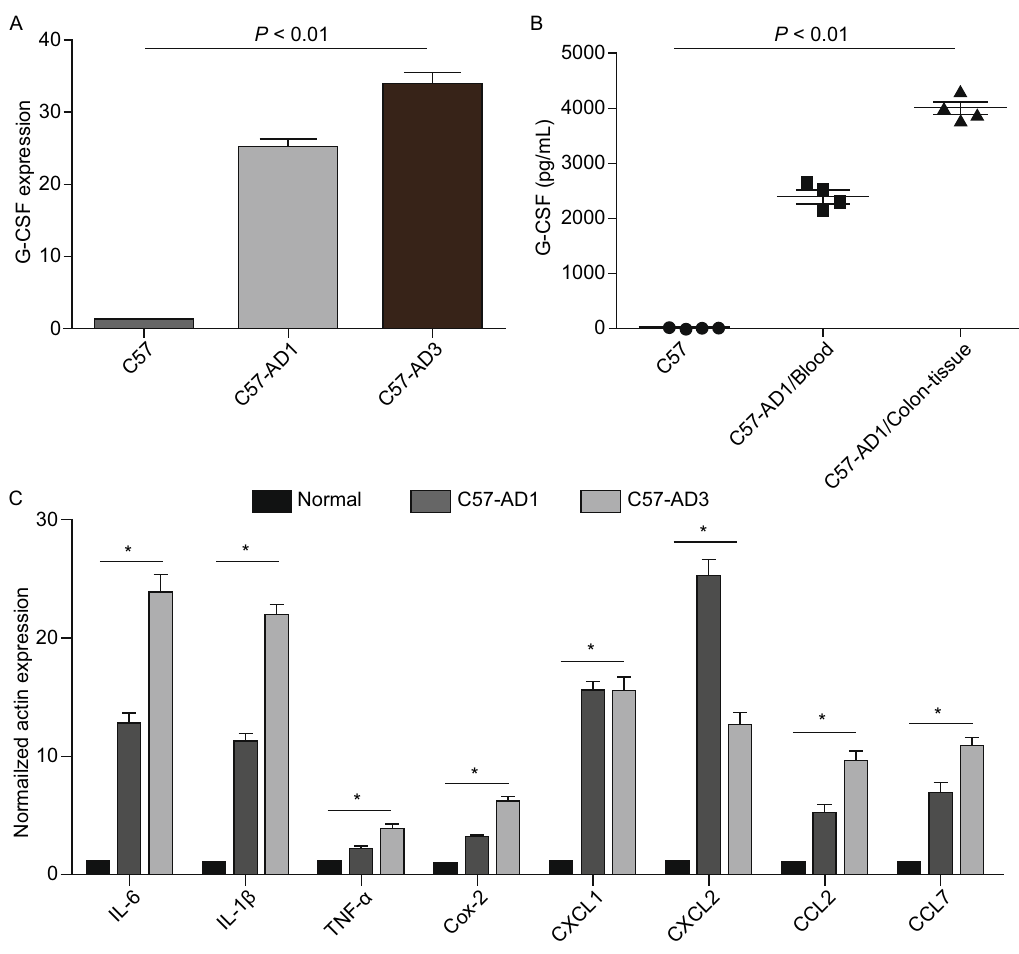
Figure 2. Detection of G-CSF expression by real-time RT-PCR and ELISA assay in C57-AD and C57 normal mice. (A) G-CSF mRNA expression in C57 and C57-AD mice. Results are given as fold increase over the mRNA level normalized β -actin and are representative of at least 3 different experiments; shown are mean ± SD from triplicate values. (B) G-CSF protein expression in colonic tissues and peripheral blood of C57 and C57-AD mice. The results represent 3 independent experiments ( n = 4). (C) Pro- in fl ammatory and chemoattrants cytokines were analyzed by real-time RT-PCR. Results are given as fold increase over the mRNA level normalized to β -actin and are representative of at least 3 different experiments; shown are mean ± SD from triplicate